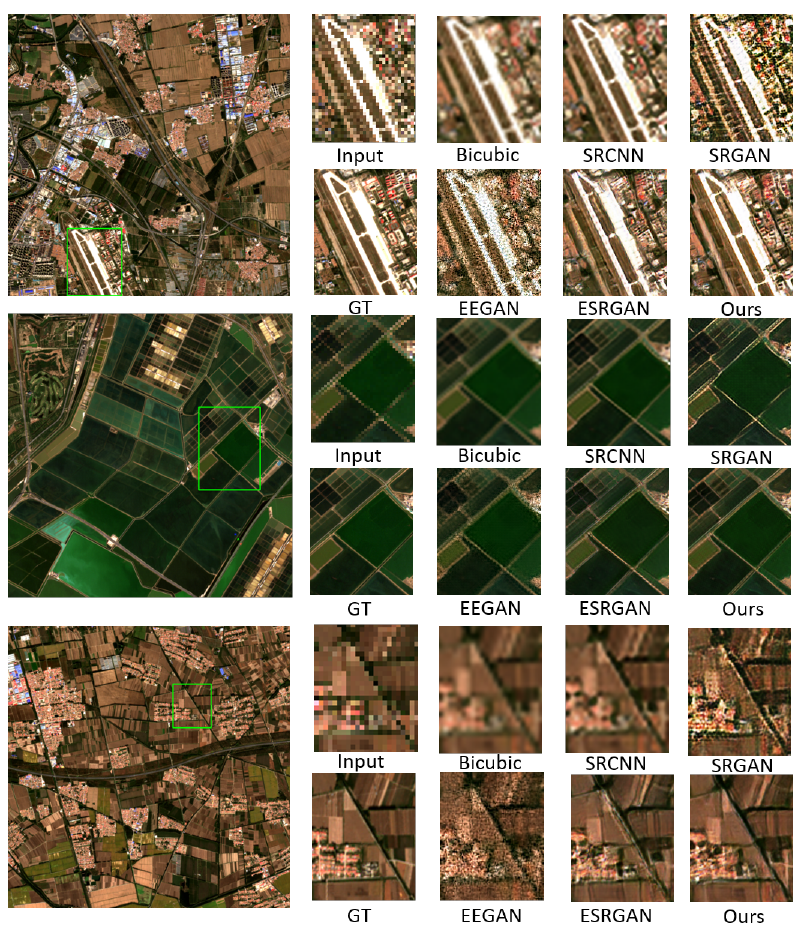
Figure 8. The quality result. We conduct experiment on varied methods. Our proposed Enlighten GAN outperforms the others.